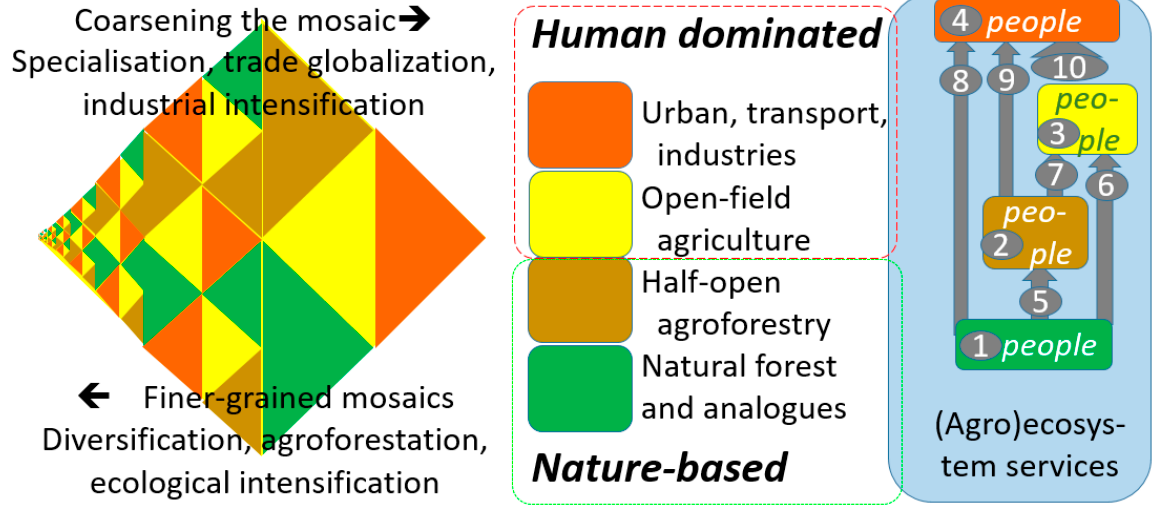
Figure 9. Relative composition (fractions of various colors) and spatial pattern (grain size of the mosaic) as two aspects of land cover at the forestry–agricultural–urban interfaces that jointly determine a set of six (agro-)ecosystem services via direct and indirect benefits people obtain (Source: [27]).